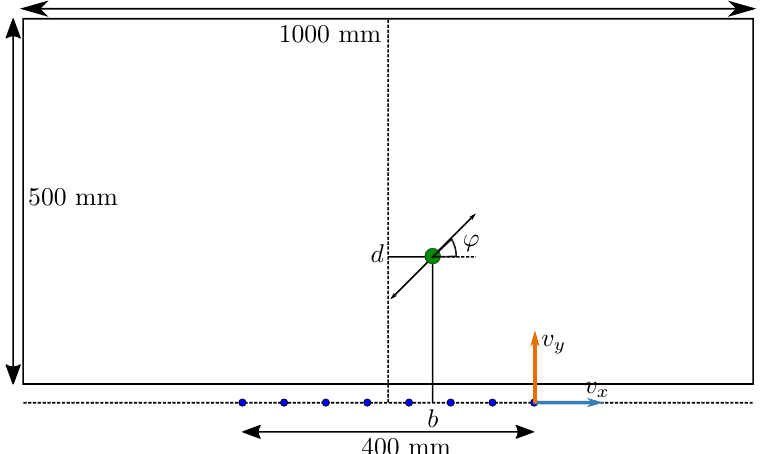
Figure 2. A schematic view of the simulated environment. The source sphere (green) has a radius of 1cm and is shown to scale. A possible movement direction is shown by the arrow (not in scale). The sensor locations are shown in blue. Parallel v x and perpendicular v y velocity components are indicated at the right-most sensor (not to scale). The area in which the source sphere is positioned is offset by 25mm from the array location, ensuring a minimal distance of 15 mm between the source’s edge and closest sensor’s centre.